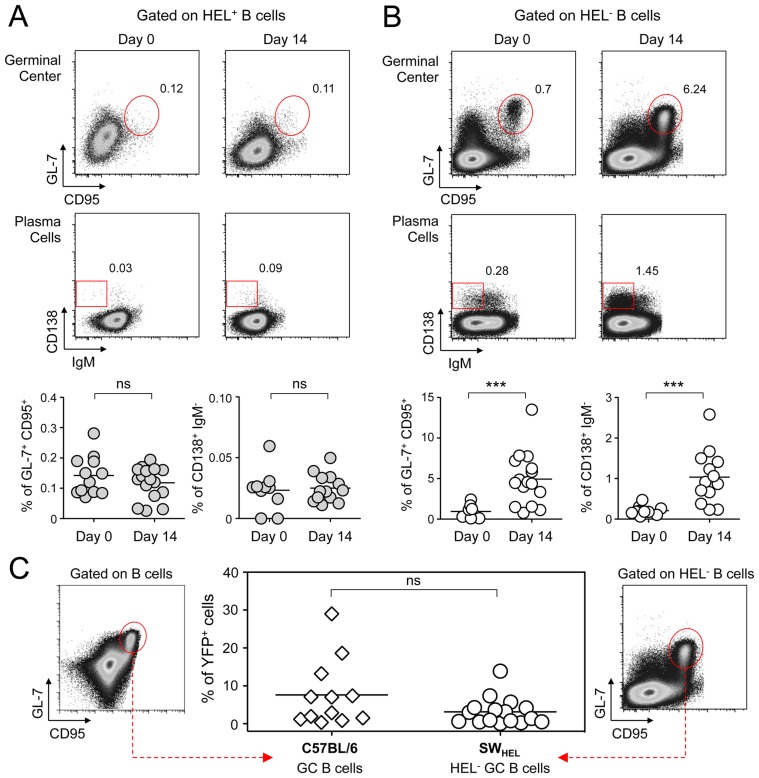
GC and plasma cell differentiation are restricted to the HEL− B cells.Splenocytes were purified from SWHEL mice at 0 and 14 dpi and analyzed by FACS. Cells were gated on (A) HEL+ or (B) HEL− B cells for phenotype analysis, monitoring the frequency of GC (CD95+ GL-7+) and plasma cells (IgM− CD138+). Top parts of the figures show representative FACS plots, bottom parts are the compilation of data obtained from different SWHEL mice (GC: day 0 n = 12; day 14 n = 16/Plasma cells: day 0 n = 10; day 14 n = 13). (C) Germinal center cells in C57BL/6 B cells and HEL− B cells harbor an equivalent frequency of YFP+ cells. Frequency of YFP+ cells in GC cells was evaluated 14 dpi by gating on the CD95+ GL-7+ population from total B cells of C57BL/6 mice (left dot plot and diamonds, n = 12) or from HEL− B cells of SWHEL mice (right dot plot and circles, n = 16). The bar represents the average percentage.